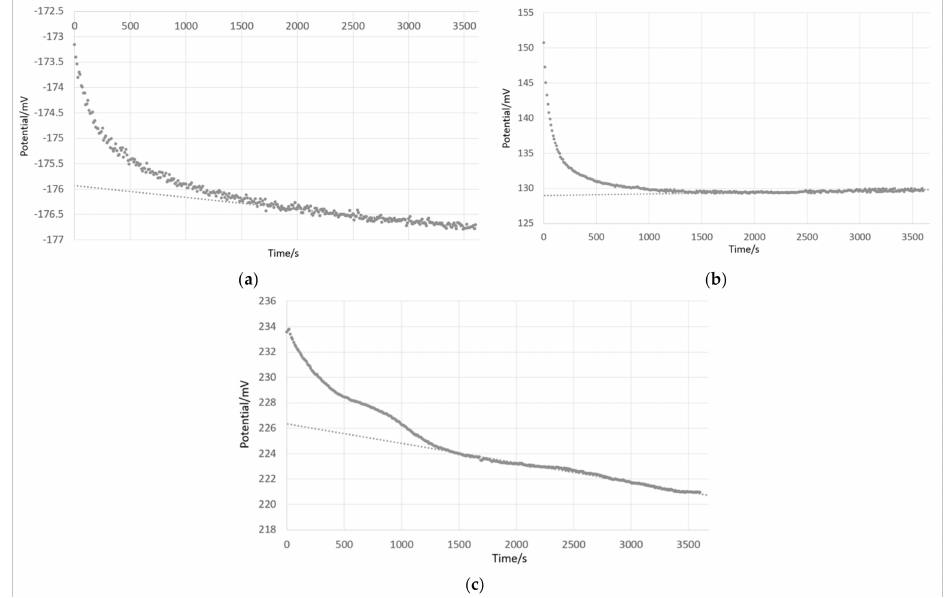
Figure 6. Potential difference measurements using two SCGE (DFM) for ( a ) pH 4.005 and pH 7.000 aqueous buffers, ( b ) pH 4.005 and 76 wt% methanol—24 wt% water, and ( c ) pH 4.005 and 70 wt% ethanol—30 wt%